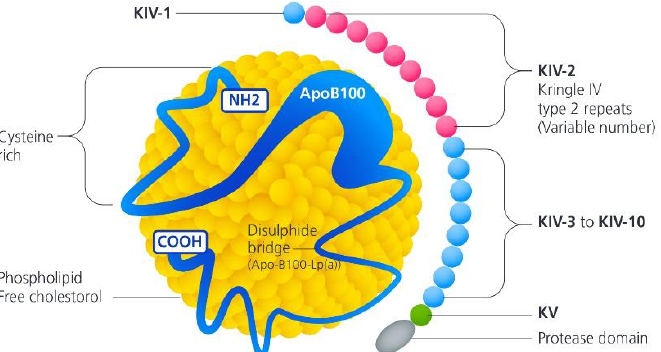
Figure 1. Schematic representation of Lp(a) particle. Lp(a) is composed of apo(a) covalently linked to apo(b100).